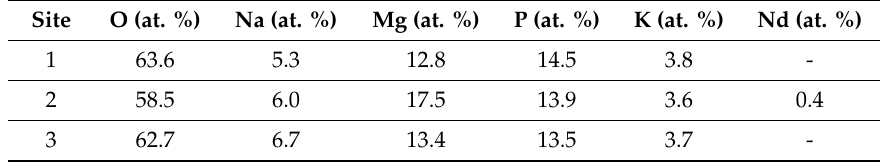
Figure 8. Backscattered electron images corresponding to cross sections of the corrosion scale formed on EZ51-IM350 alloy immersed in PBS solution for di ff erent times. ( a , b ) 48 h, ( c , d ) 144 h. Table 1. EDS (Energy-dispersive X-ray spectroscopy) microanalyses corresponding to the points marked in Figure 8b of the corrosion scale formed over the EZ51-IM350 alloy immersed in PBS solution for 48 h. The presence of Nd was attributed to the possible presence of non-corroded second phases embedded in the corrosion scale and within the excited volume of EDS measurement (Figure 8d). Site O (at.